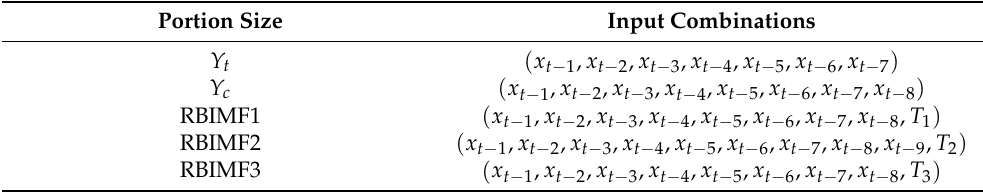
Table 4. Inputs and feature combinations for each component.